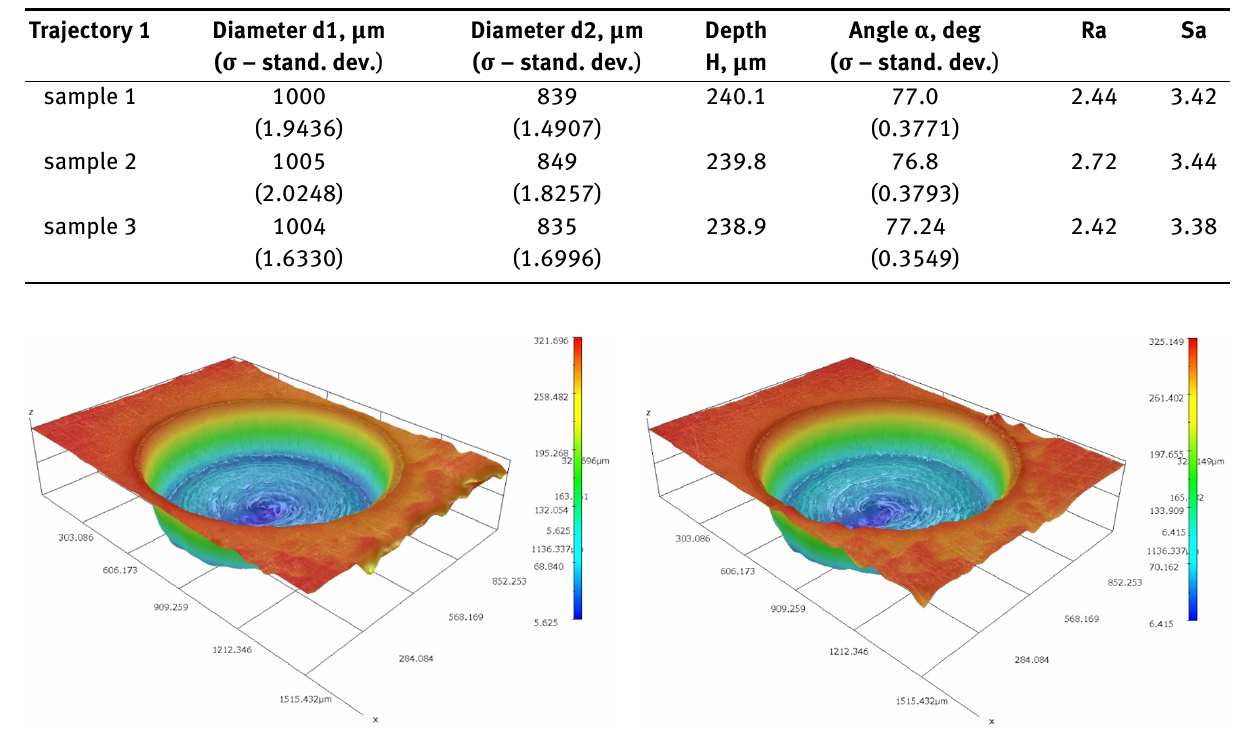
Figure 7: 3D profile of the first sample for trajectory No. 2.